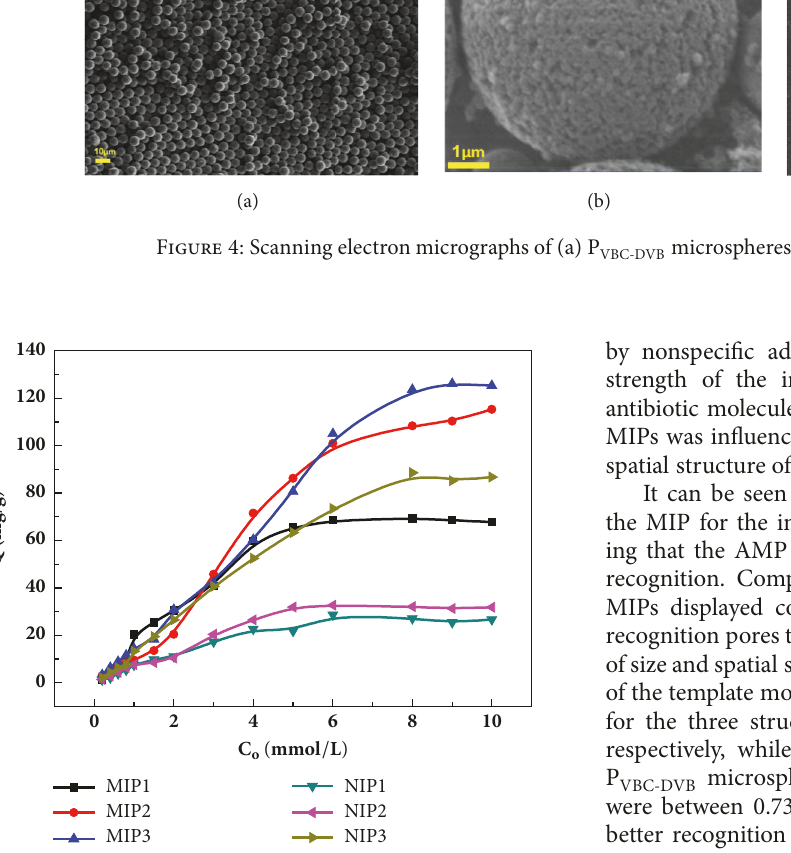
Figure5:Equilibriumadsorptioncurvesofampicillinwithdifferent MIPs and